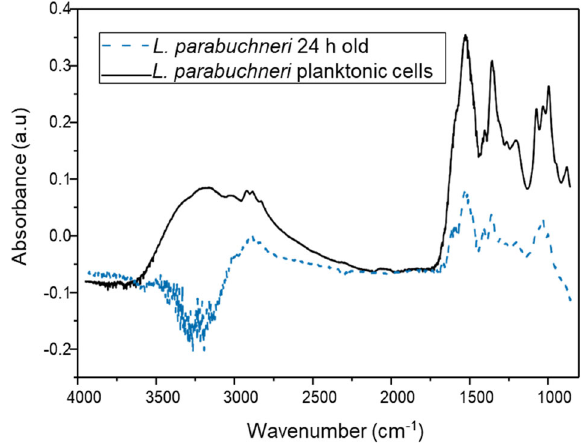
Fig. 3 Molecular changes in the planktonic form of L. para- buchneri vs 24 old bio fi lms. Comparison of IR spectra of 24 h old L. parabuchneri bio fi lm performed in fl ow-through mode (black spectrum) vs. planktonic cells at static conditions (dashed blue